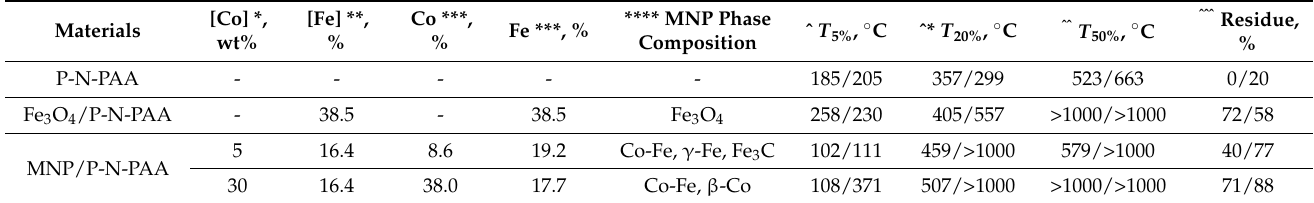
Table 6. Thermal properties of